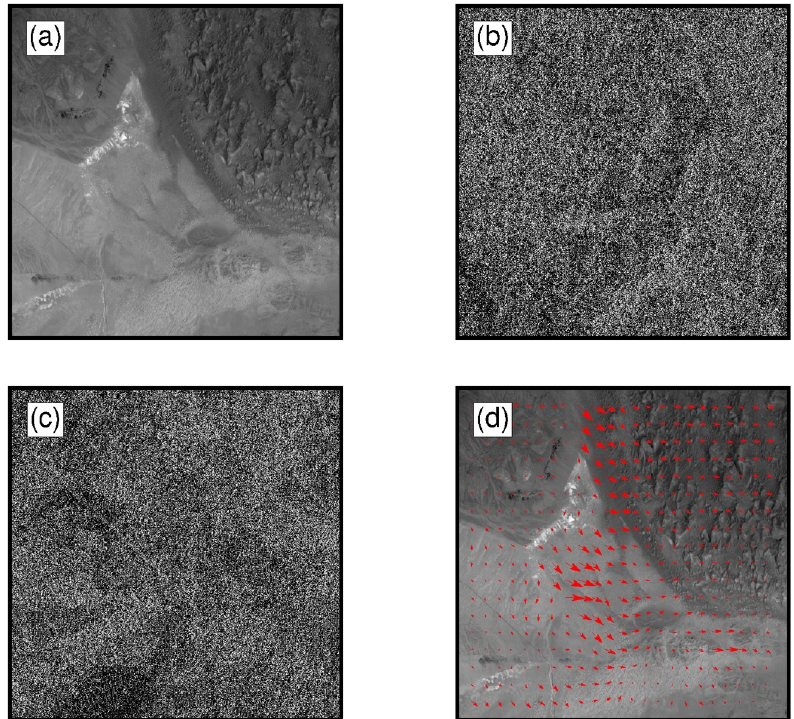
Figure 2. ( a ) A Landsat 5 image, ( b ) its orientation image’s intensity component and ( c ) imaginary component, and ( d ) the displacement shown in vector fields. component, and ( d ) the displacement shown in vector